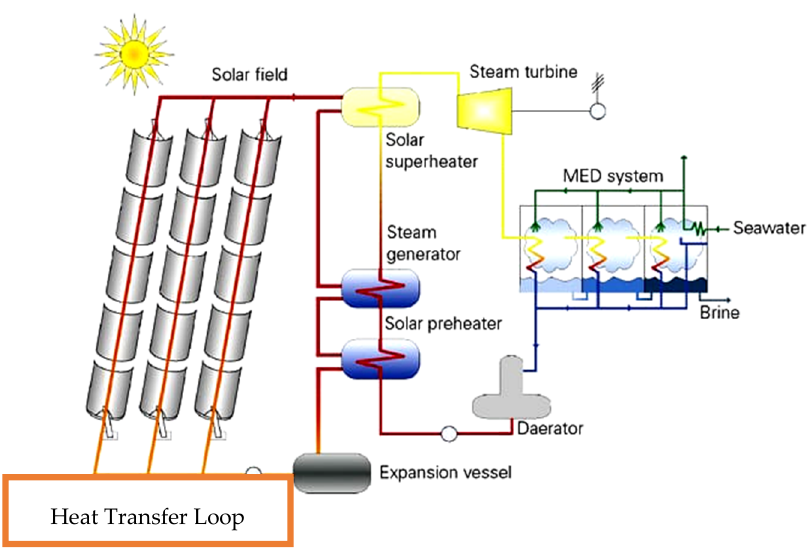
Figure 9. Solar thermal-based power generation and desalination system [112].